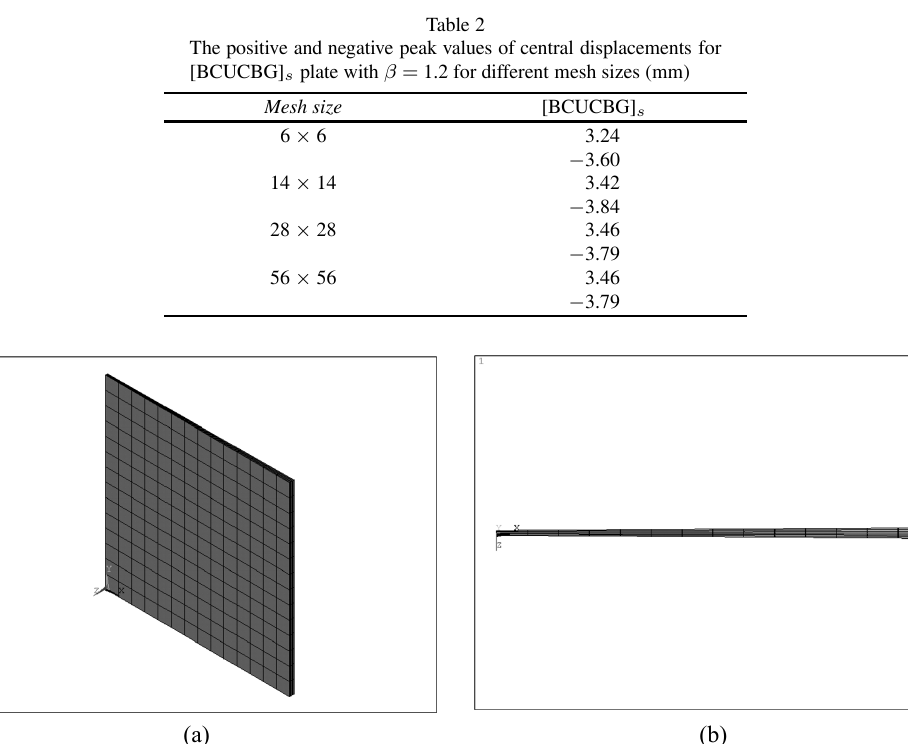
Fig. 3. (a) Finite element model of the tapered laminated plate. (b) Cross section of the tapered laminated